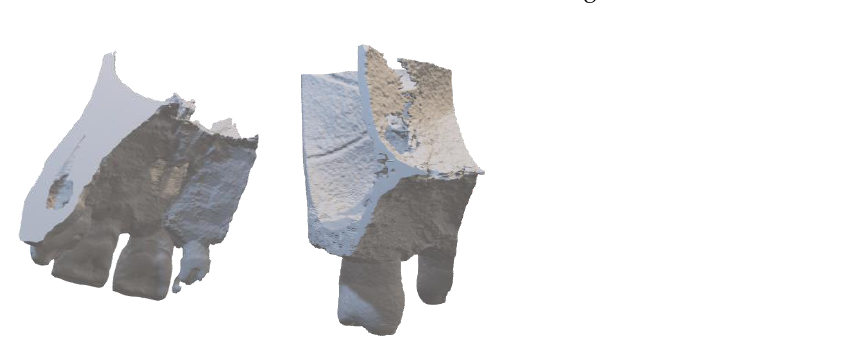
Figure 9. Visualization of resorption in 3D. This view is displayed in front of the users wearing Microsoft HoloLens 2.